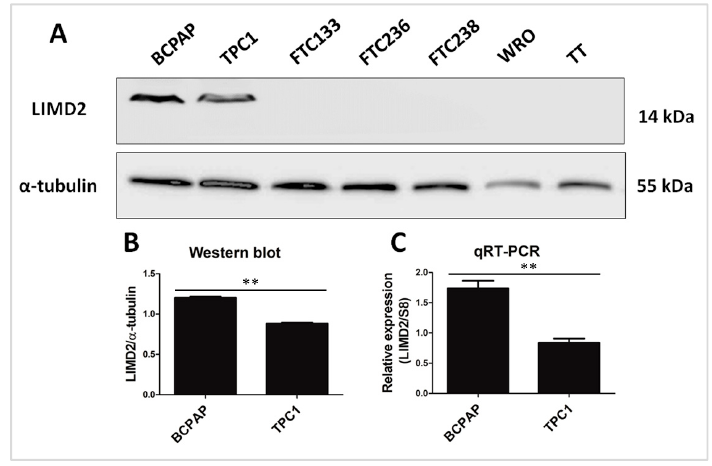
Figure 1. LIMD2 expression in thyroid cell lines. ( A ) Representative image of Western blot analysis shows that LIMD2 is exclusively expressed in papillary (BCPAP and TPC1), while it is not expressed in follicular (FTC133, FTC236, FTC238, and WRO) and medullary (TT) thyroid carcinoma cell lines. The α -tubulin was used as a loading control; ( B ) Densitometry measurement of LIMD2 expression. The results are the ratio of LIMD2 / α -tubulin from three independent experiments. Each column represents the mean ± SD; ( C ) LIMD2 expression in BCPAP and TPC1 cell lines. S8 was used as an internal control. Each column represents the mean ± SD of three experiments performed in triplicate. ** p < 0.01.